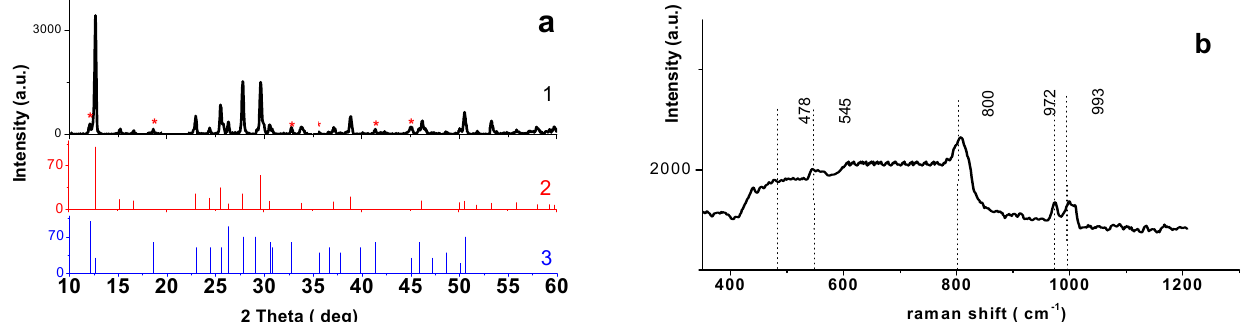
Figure 3. ( a ) XRD pattern of NaV 3 O 8 (1) and line diagrams of powder pattern for NaV 3 O 8 (PDF2, N ◦ 28-1178) (2) and NaV 6 O 15 (PDF2, N ◦ 24-1155) (3); ( b )Raman spectrum for NaV 3 O 8 .